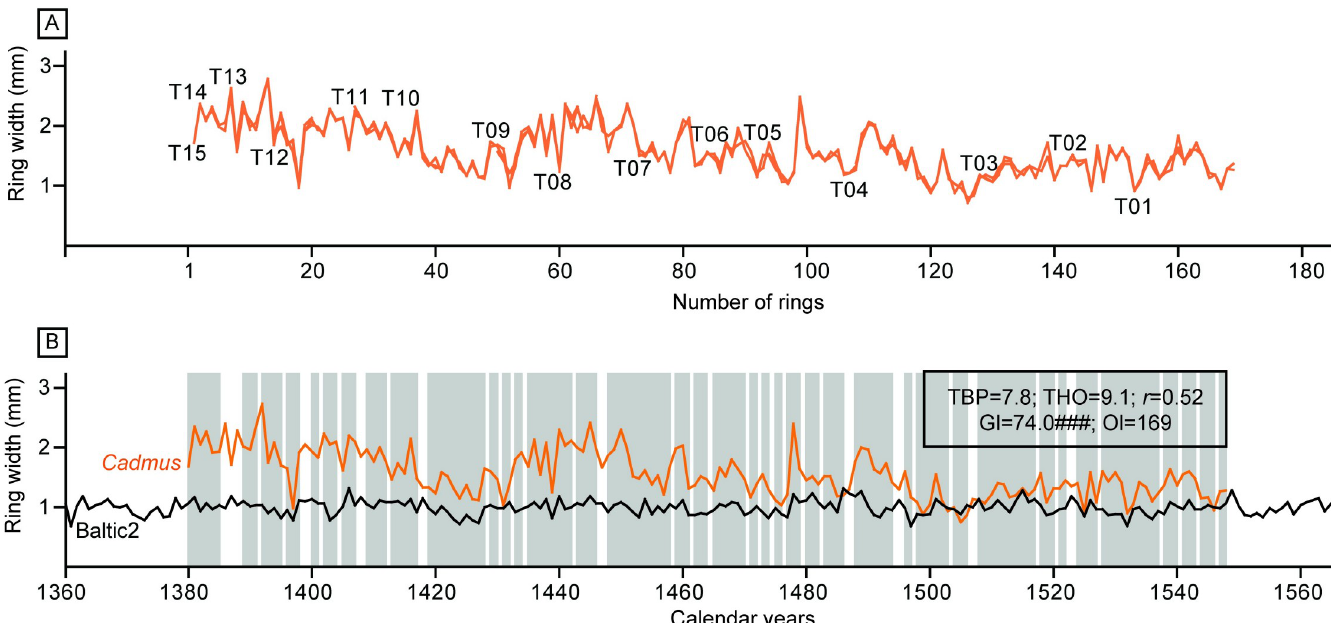
Fig 6. Results of the dendrochronological research. (A) Cross-match between the tree-ring series obtained from each individual tile. (B) Absolute dating of the mean curve obtained from averaging the measurements of the individual tiles ( Cadmus ) crossdated with the Baltic2 chronology. TBP, Student’s t -value as implemented by [60] for tree-ring studies; THO, Student’s t -value as implemented by [43]; r , correlation coefficient; Gl, percentage parallel variation between the overlapping portion of the compared tree-ring series [61], accompanied by its signification level; Ol, overlap (see S3 Text for details about the statistical tests